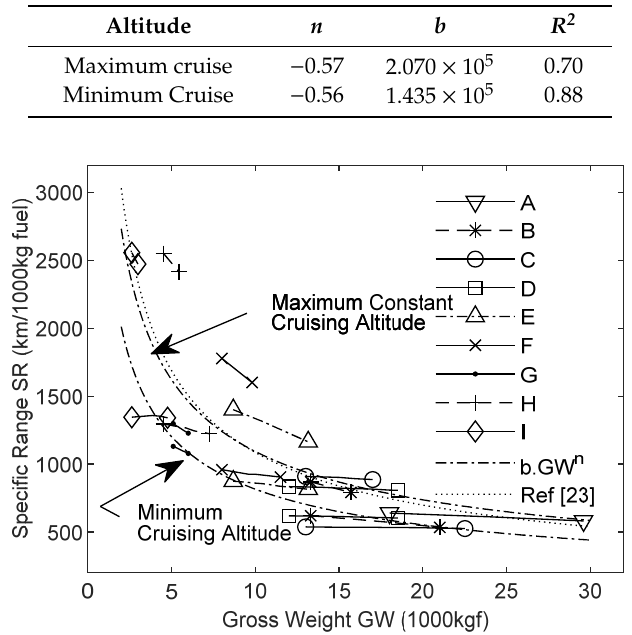
Table 3. Specific range (km / 1000kg fuel) power-fit to gross weight (kgf) at the maximum constant Table 3 . Specific range (km/1000kg fuel) power-fit to gross weight (kgf) at the maximum constant altitude, and at the minimum cruise altitude: SR = b GW n altitude, and at the minimum cruise altitude: SR = b GW (cid:2924) .